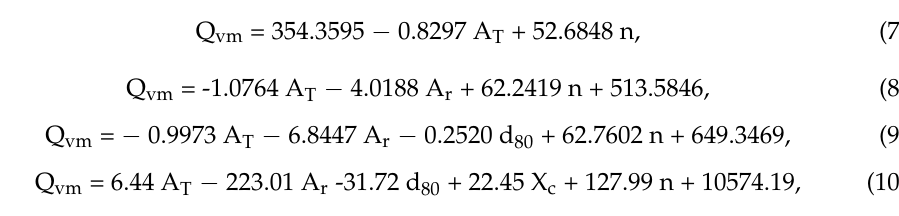
Table 7. Multiple regression analysis of dependence of the excavator productivity Q vm on analyzed determinants. Regression Summary for Dependent Variable: Excavator Productivity Mark Equation in Loose State of Material Q vm (m 3 /h)